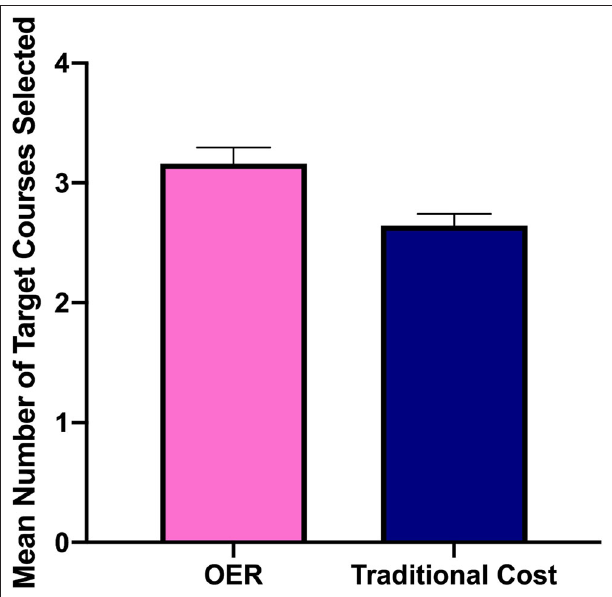
FIGURE 2 | Overall mean cost of textbooks in courses selected between OER and Traditional Cost